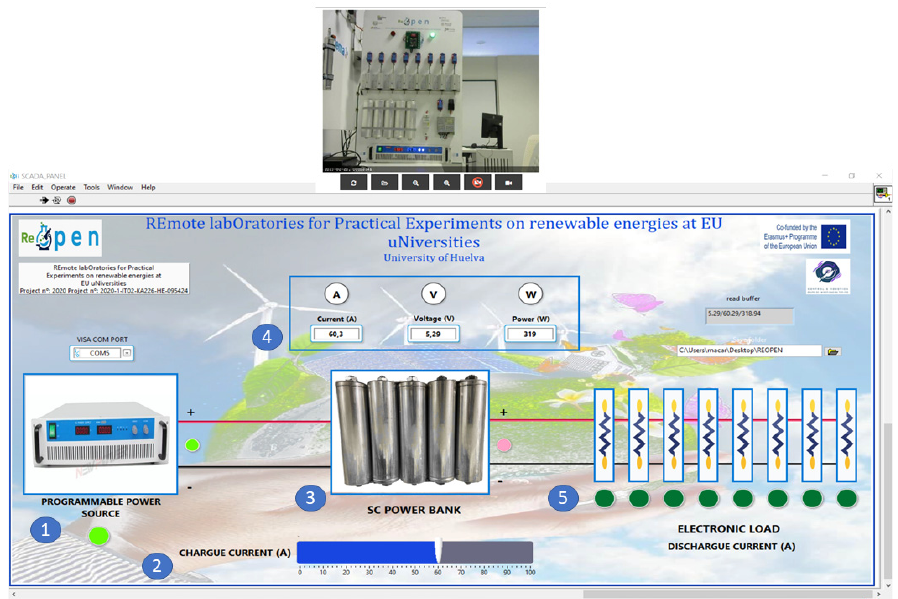
Figure 12. User interface of the remote laboratory of supercapacitor power bank: charging process.